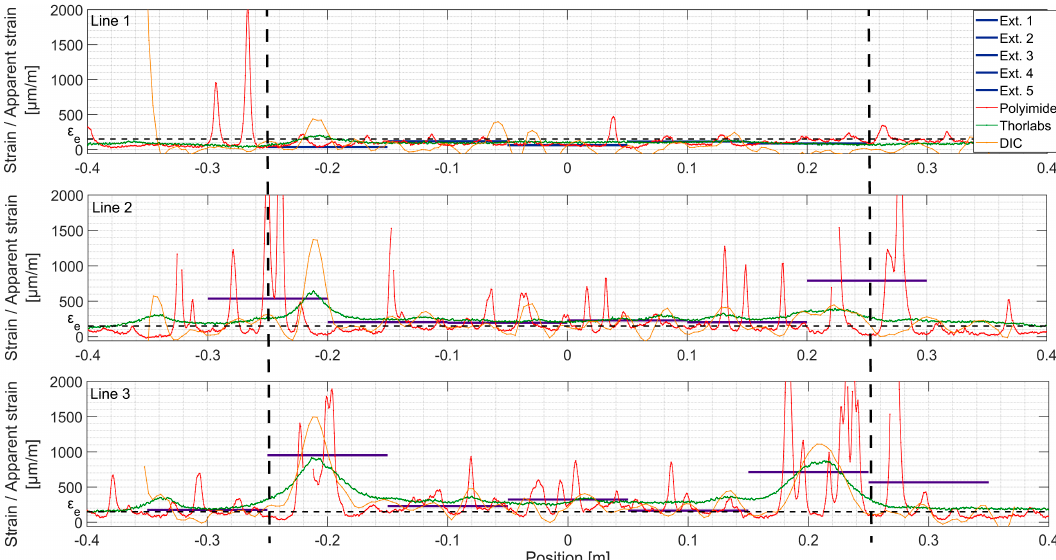
Figure 12. Strains measured with different techniques, load step 3, F = 90 kN; the constant bending moment zone is marked with dashed lines.